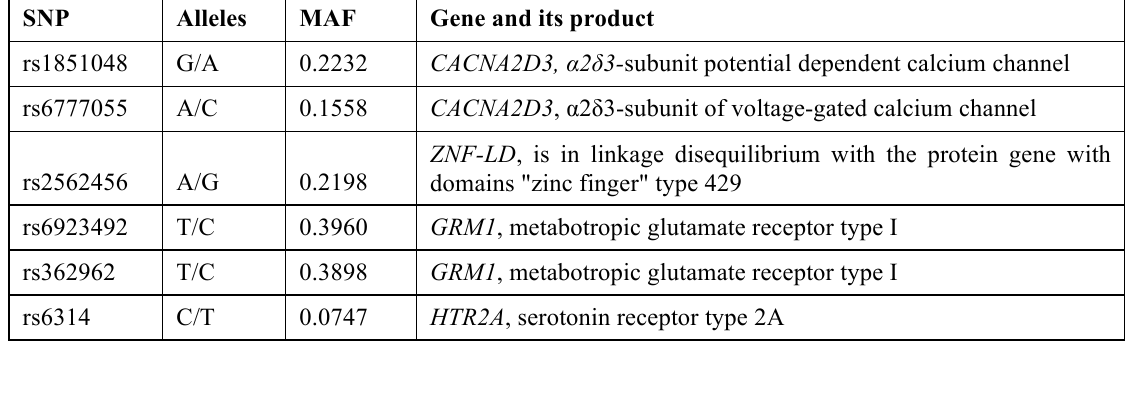
Table 2: Characteristics of selected SNPs